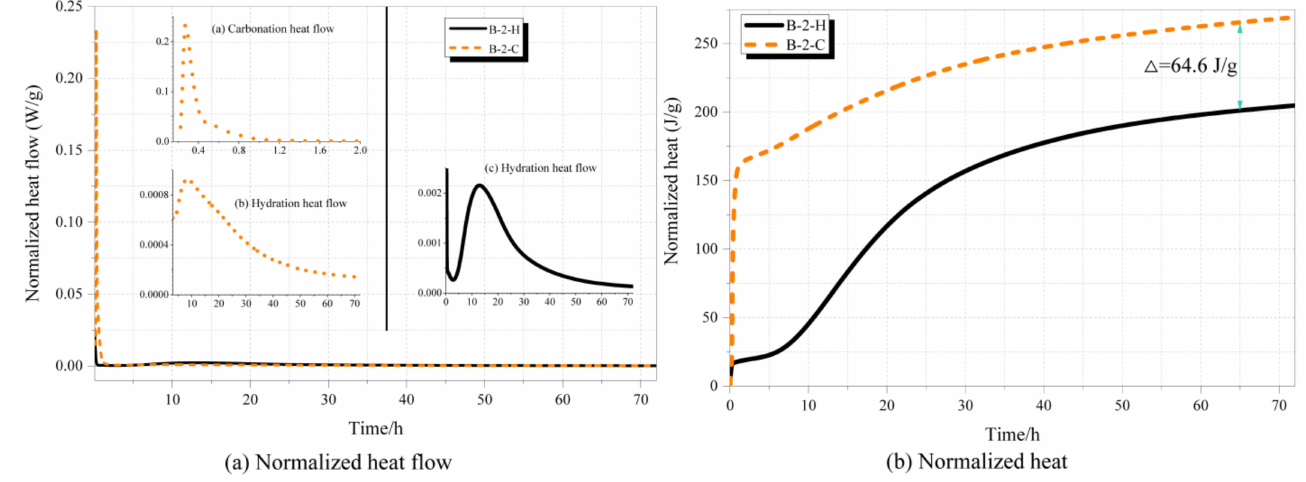
Figure 9. Normalized carbonation–hydration heat flow ( a ) and normalized heat ( b ) of B-2 sample. Normalized carbonation–hydration heat flow and normalized heat release of B-3 are shown in Figure 10. The sample of B-3 consisted of 10% SF, 90% cement, 2% air entrainment typed superplasticizer, and 2% PP fiber by volume; the w/b ratio was 0.25. it was found that carbonation heat flow in B-3-C was quite unstable, with a heat peak over 0.02 W/g and a second peak flow of about 0.015 W/g. After the process of carbonation reaction, a normal hydration heat flow was obtained from the figure. For this one, the peak flow was 0.0025 W/g, while this value was 0.0017 W/g in a referenced sample of B-3-H. Moreover, the time for hydration peak flow was pushed forward in B-3-C when compared to that in B-3-H. For normalized heat released behavior of B-3 as presented in Figure 10b, a similar sharp increase, as well as the heat difference between B-3-C and B-3-H of 36.4 J/g, were both observed from